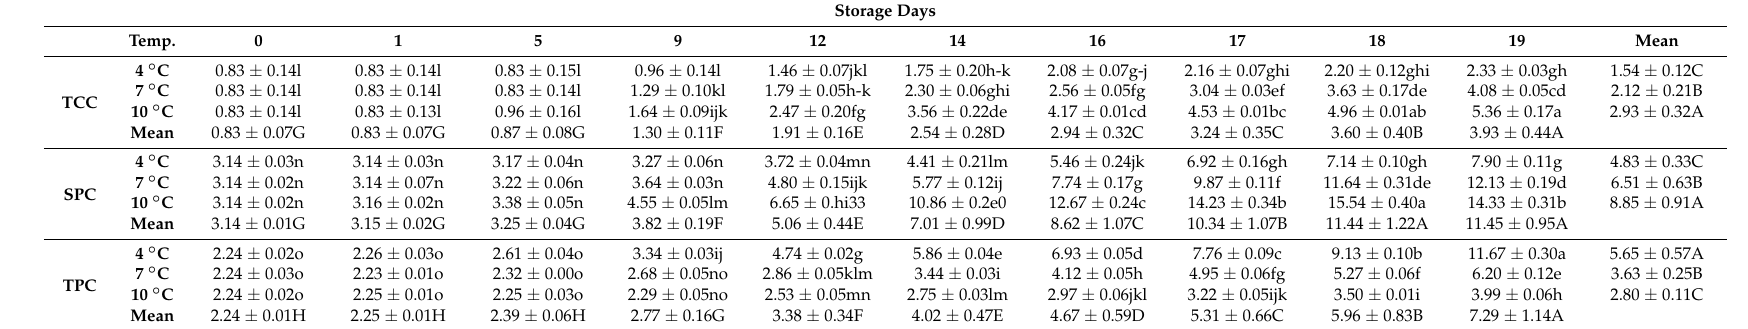
Table 4. Means values and standard deviation of microbial count (Log 10 CFU/mL) of pasteurized milk stored at different temperatures. Storage Days